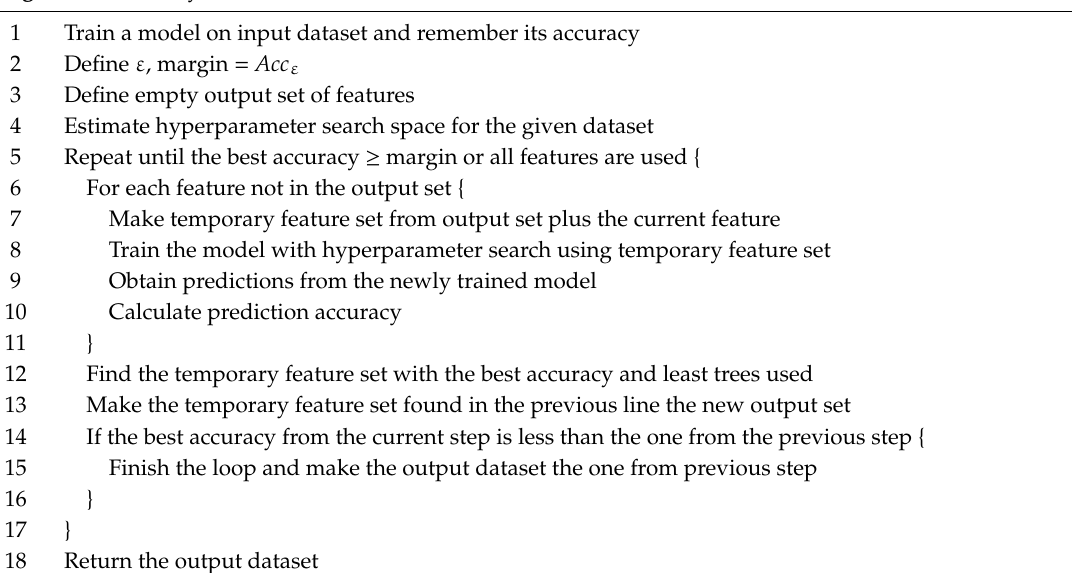
Algorithm 1 Greedy Feature